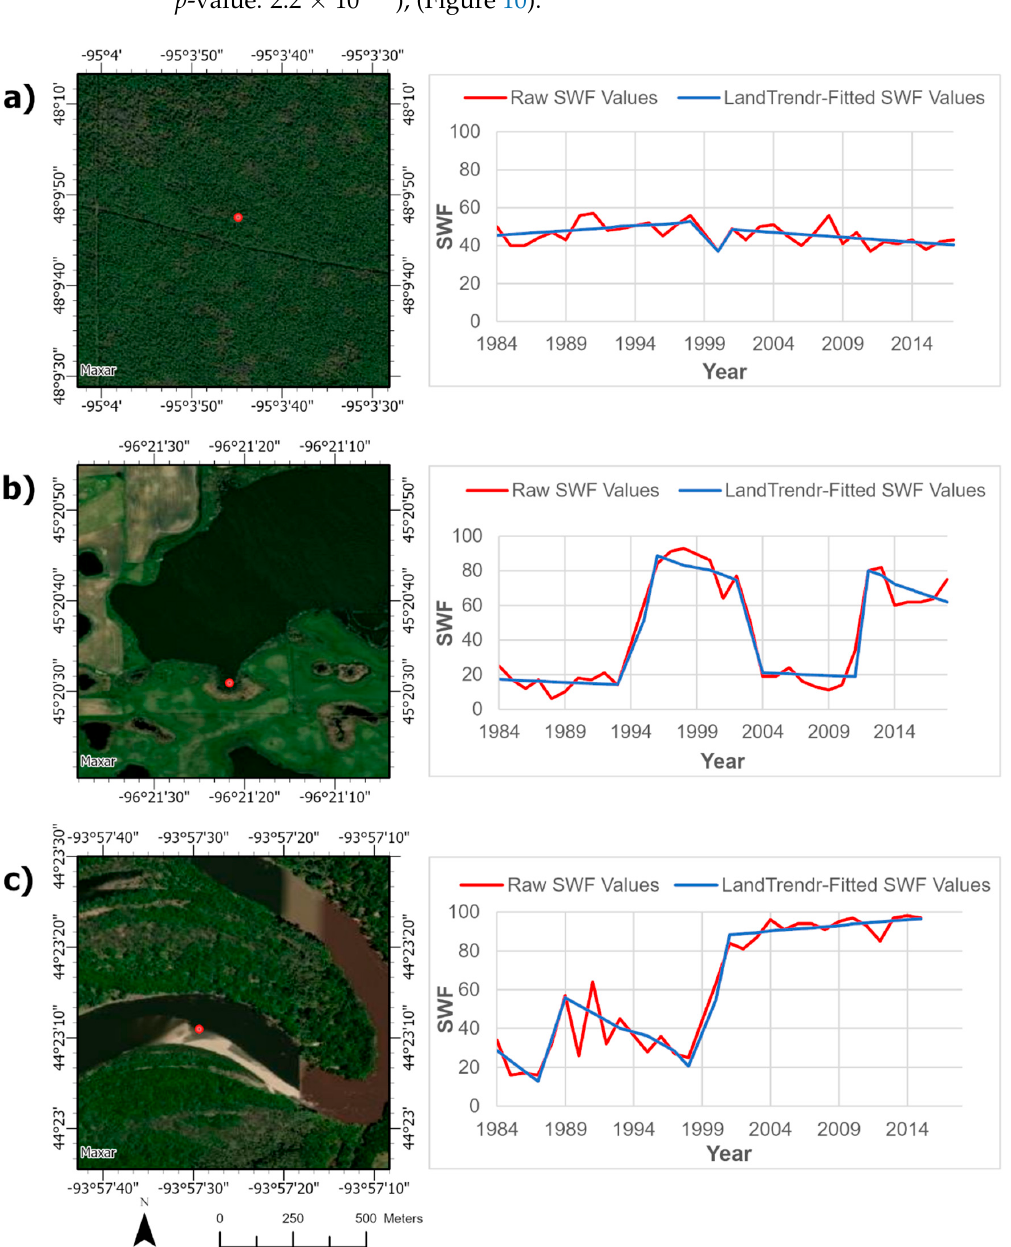
Figure 7. Examples of the LandTrendr fit for individual pixels. LandTrendr produces consistent temporal segmentations across different wetland types and expected variability of the system. Small fluctuations in surface water amount from year to year are removed, whereas long-term trends over time are identified. ( a ) LandTrendr fit for a peatland at the edge of Red Lake. Despite the fact that changes in this wetland are relatively small over time (ranging from 30–60% SWF), it still identifies a general trend of higher values around 1998. It also identifies a drop in values in 1999, which may not be significant in the larger context. ( b ) LandTrendr fit for the edge of a large prairie pothole near Big Stone Lake. LandTrendr effectively models extreme changes from dry (in the 1980s and 2000s) to periods with near-total inundation due to high precipitation (the late 1990s and early 2010s). ( c ) LandTrendr fit for the Minnesota River near St. Peter. Despite a high degree of variability in the early 1990s, LandTrendr can identify when this location became part of the main channel in the early 2000s, correctly identifying two key time periods at this